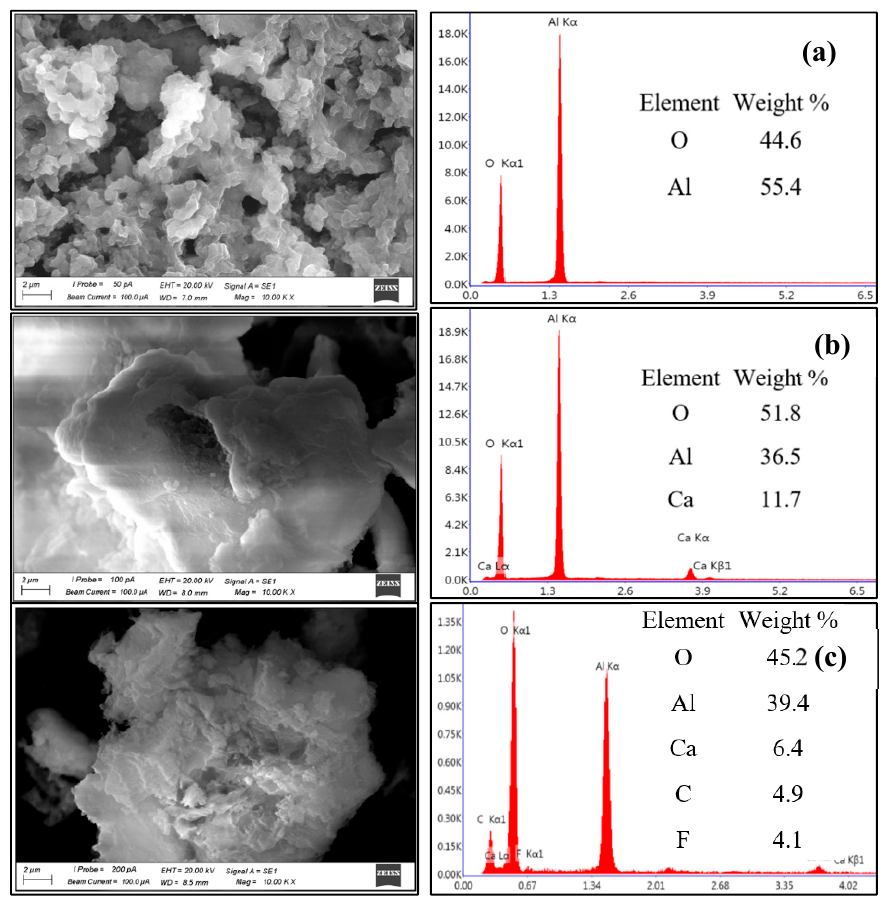
Figure 2. ESEM and EDX images of ( a ) mesoporous alumina, ( b ) COMA before the adsorption of fluoride, and ( c ) COMA after adsorption of fluoride.